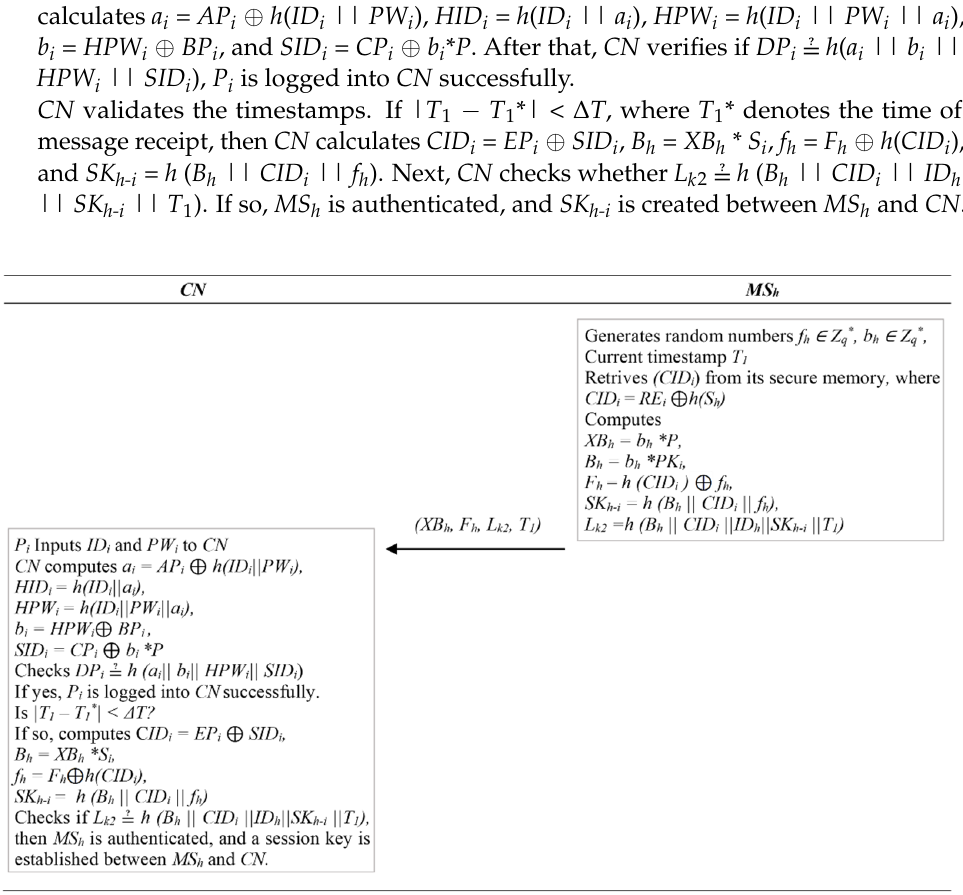
Figure 4. Authentication P-I.